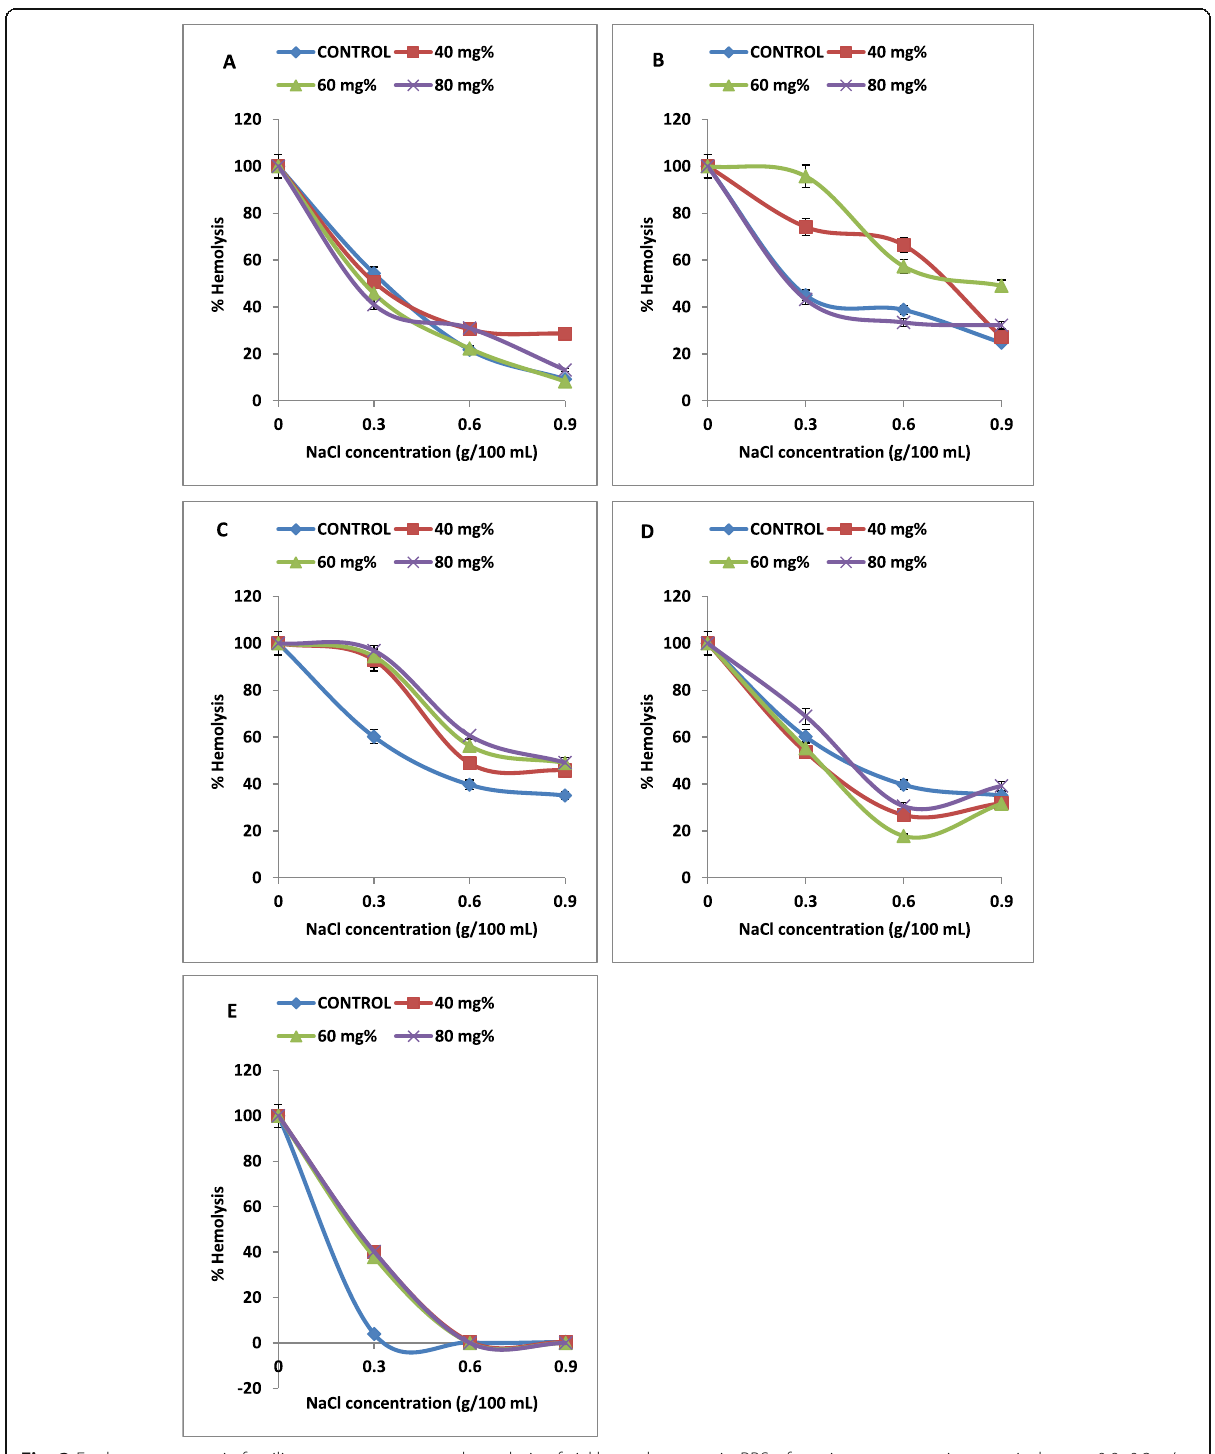
Fig. 3 Erythrocyte osmotic fragility curves: percentage hemolysis of sickle erythrocytes in PBS of varying concentrations equivalent to 0.9 – 0.3 g/ 100 mL NaCI in the presence of fractionated leaf extracts of T . catappa . a Petroleum ether. b n -hexane. c Chloroform. d Ethylacetate. e Residual